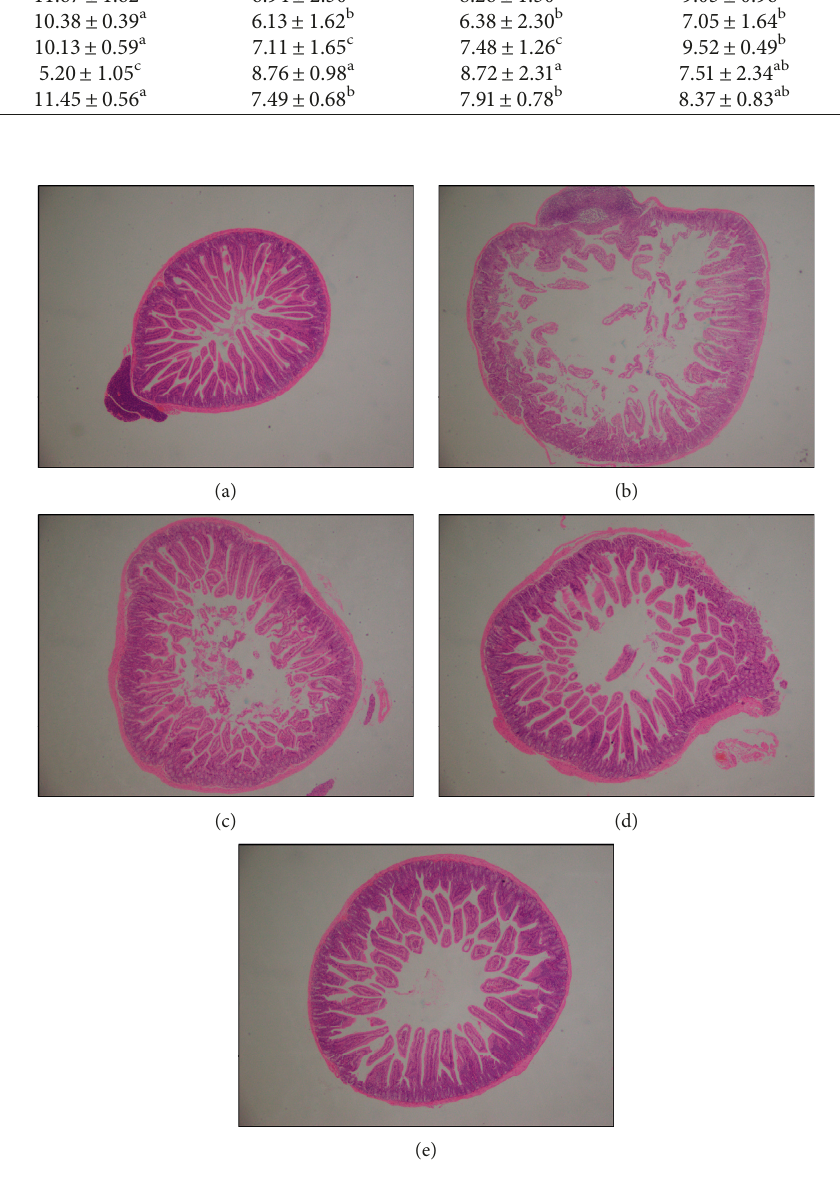
Figure 3: Morphological observation of small intestine tissue in mice with activated carbon-induced constipation. LB : Lactobacillus delbrueckii subsp. bulgaricus (1.0 × 10 9 CFU/kg b.w. gavage); LP-CQPC02-L: Lactobacillus plantarum CQPC02 (1.0 × 10 8 CFU/kg b.w. gavage); and LP-CQPC02-H: Lactobacillus plantarum CQPC02 (1.0 × 10 9 CFU/kg b.w. gavage). (a) Normal. (b) Control. (c) LB. (d) LP- CQPC02-L. (e)